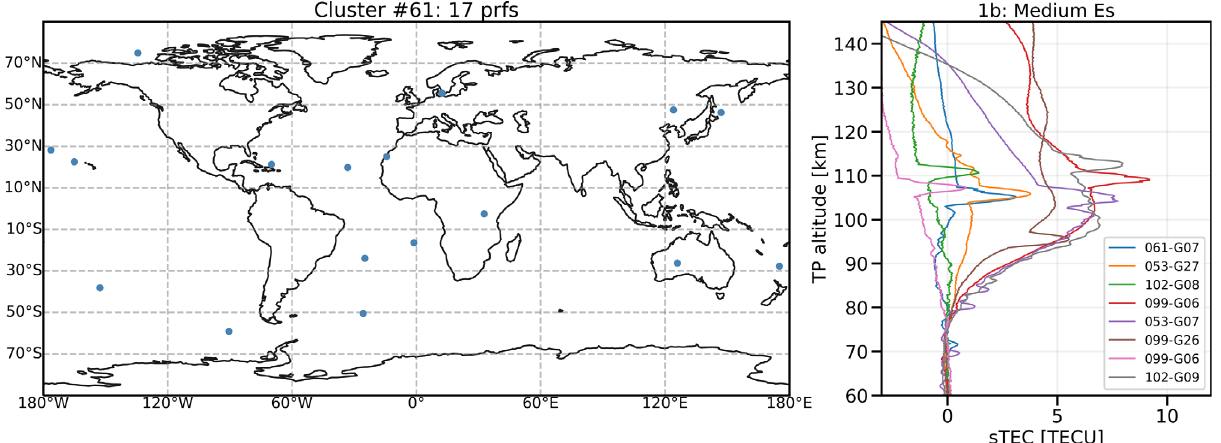
Fig. 11. Ionospheric perturbations example cluster. The left map shows the location of the 17 sTEC pro fi les within the cluster. On the right, 8 randomly selected pro fi les from the cluster. All the pro fi les show similar Es